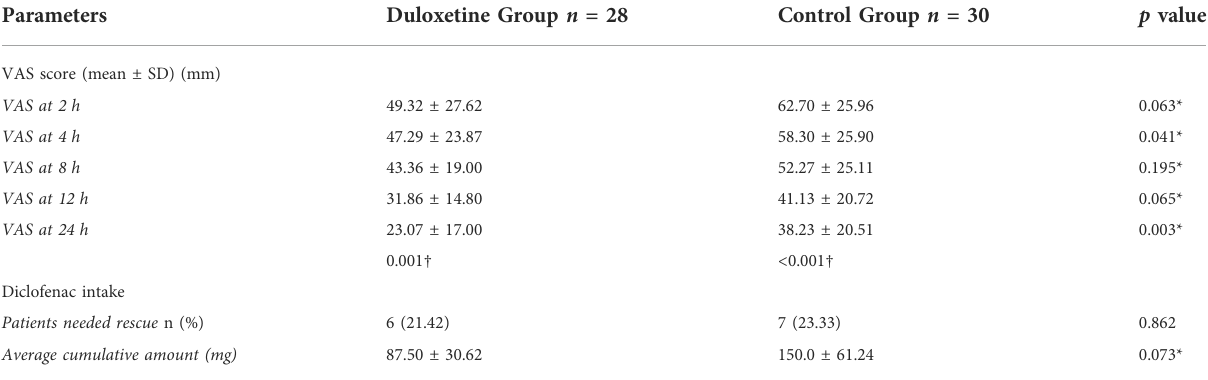
TABLE 3 Pain parameters post LC in the two study groups.